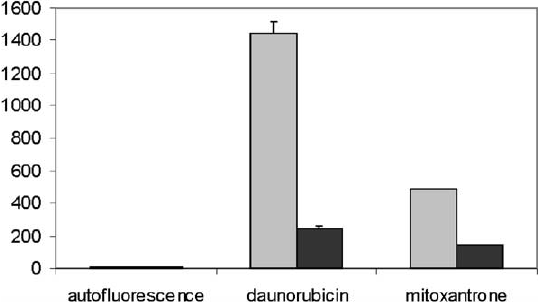
Fig. 3. Drug accumulation of daunorubicin and mitoxantrone in MCF-7 cells under normoxia and hypoxia. MCF-7 cells were ex- posed to 20 µ M of the fluorescent doxorubicin analogue daunoru- bicin, or 20 µ M mitoxantrone for 1 hour. Results shown are means ± SD of two experiments. Grey boxes: normoxia, dark boxes: